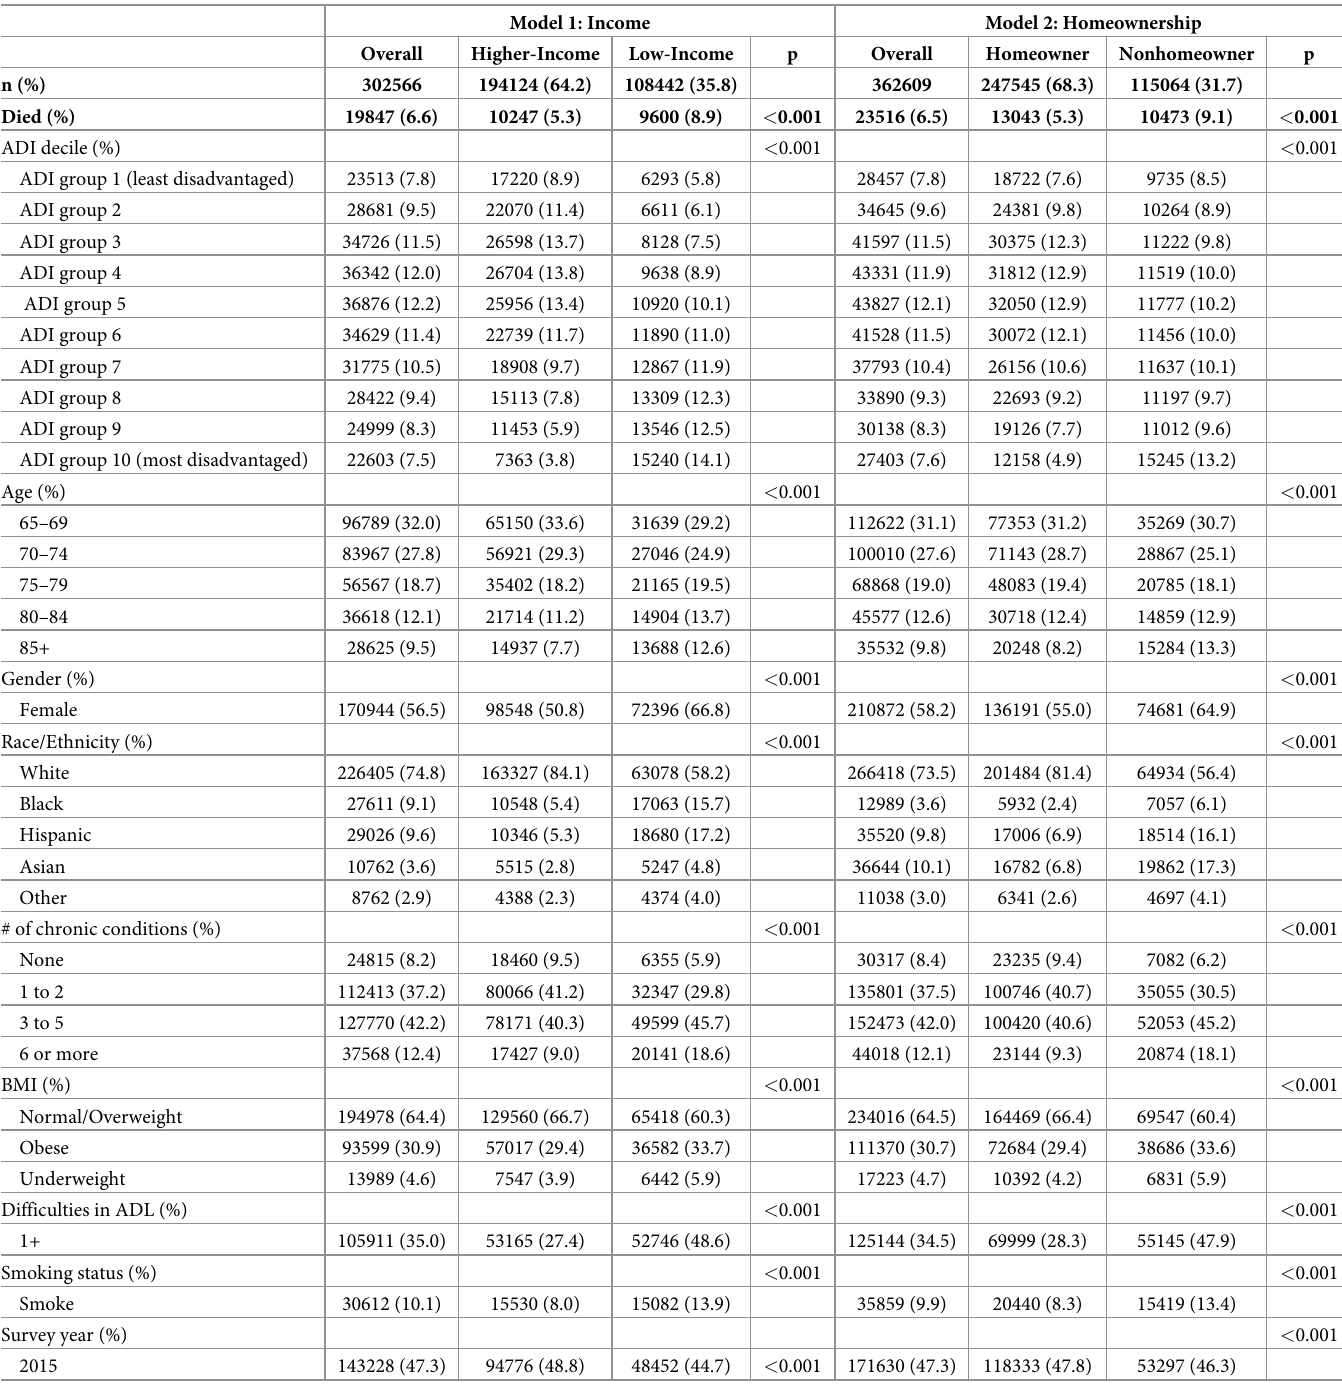
Table 1. Descriptive